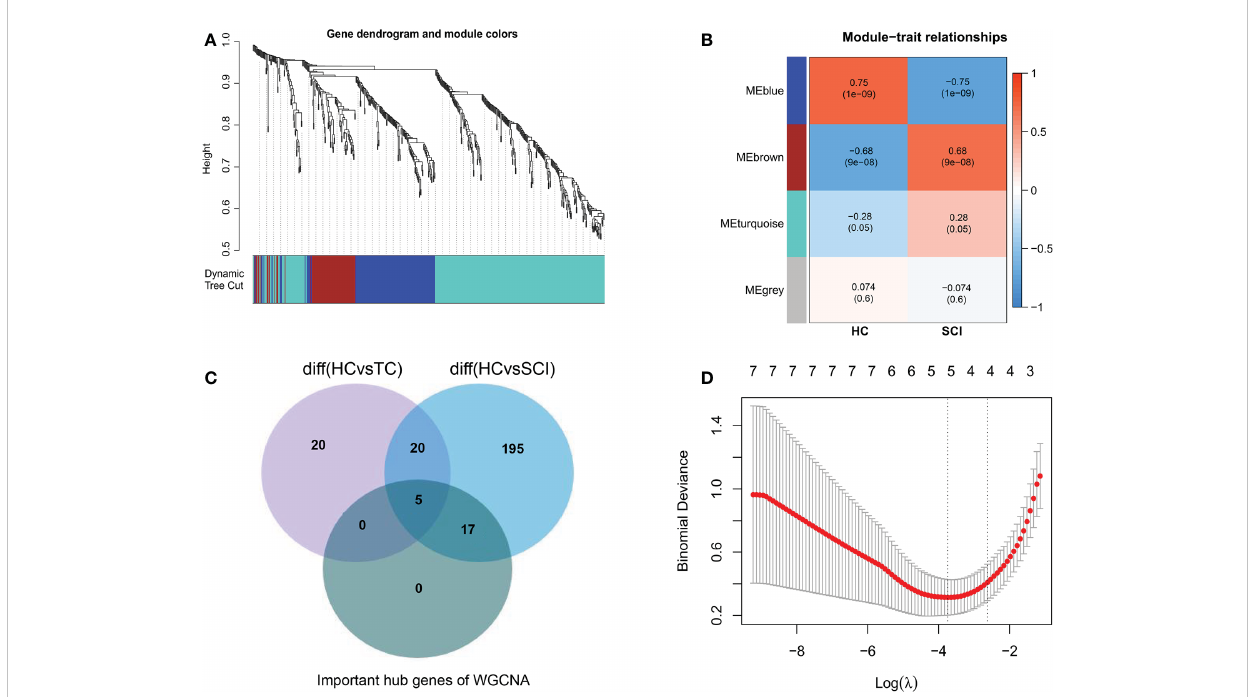
FIGURE 3 Identi fi cation of characteristic biomarkers of SCI. (A) Dendrogram of immune-related genes in SCI. Each branch of the fi gure represents one gene, and every color below represents a coexpression module. (B) Heatmap of the correlations between module signature genes and clinical features of SCI. Each row represents a module trait gene, and each column represents a trait. Each cell includes the corresponding correlation and p value. (C) WGCNA hub immune-related genes, DEIGs in SCI, and DEIGs in the TC Venn diagram. (D) LASSO logistic regression analysis. A P value < 0.05 was regarded as statistically signi fi cant. SCI, spinal cord injury; HC, healthy uninjured control; TC, trauma control with noncentral nervous system injury; WGCNA, weighted gene coexpression network analysis; AUC, area under the curve; DEIGs, differentially expressed immune-related genes.